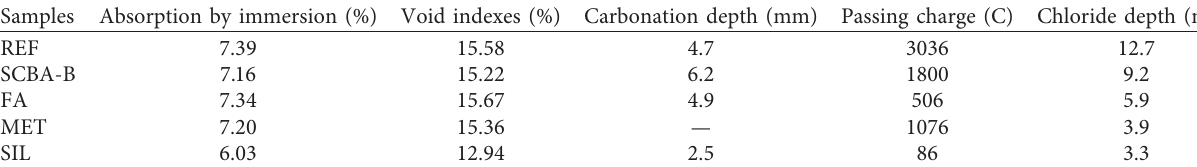
Table 6: Data of the durability